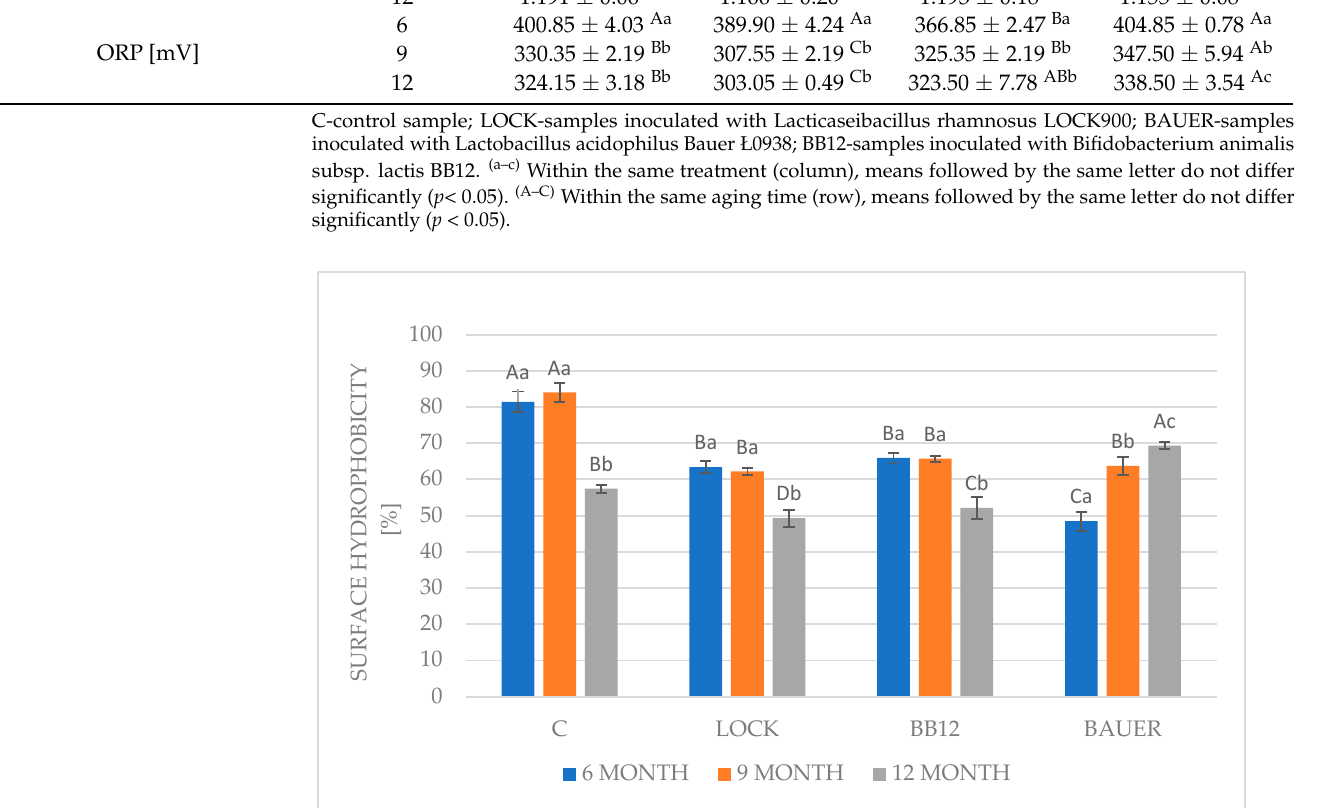
Figure 1. Surface hydrophobicity of the fermented meat products during storage [C-control sample; LOCK-samples inoculated with Lacticaseibacillus rhamnosus LOCK900; BAUER-samples inoculated with Lactobacillus acidophilus Bauer Ł 0938; BB12-samples inoculated with Bifidobacterium animalis subsp. lactis BB12. (a–c) Within the same treatment, means followed by the same letter do not differ significantly ( p < 0.05). (A–D) Within the same aging time, means followed by the same letter do not differ significantly ( p < 0.05)].